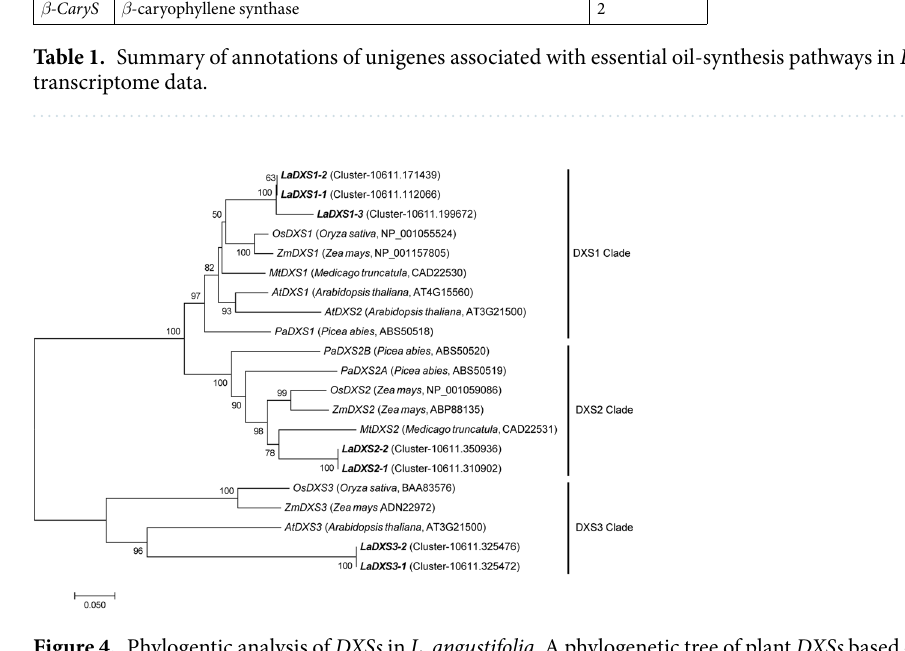
Figure 4. Phylogentic analysis of DXSs in L. angustifolia . A phylogenetic tree of plant DXSs based on the neighbor-joining method. Six DXSs from L. angustifolia were in